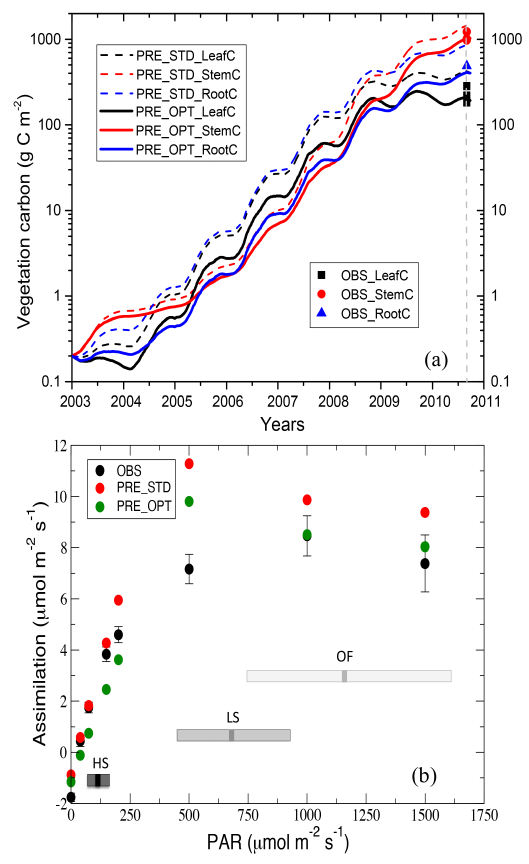
Figure 3. (a) CLM simulated change of leaf carbon (PRE_STD_LeafC), stem carbon (PRE_STD_StemC), and root carbon (PRE_STD_RootC) with default parameters and change of those (PRE_OPT_LeafC, PRE_OPT_StemC, and PRE_OPT_RootC) simulated with optimized parameters for the pretreatment period between year 2003 and 1 Septem- ber 2010 (dashed gray line). Observational estimations of leaf (OBS_LeafC; 221.1, 283.8, and 181.9gCm − 2 ), stem (OBS_StemC; 1011.2, 973.8, and 1220.1gCm − 2 ), and root (OBS_RootC; 488.4gCm − 2 ) are based on measured stem diam- eters at breast height and allometric relationships from similarly aged loblolly pine (Baldwin and Feduccia, 1987; Naidu et al., 1998; Vanlear et al., 1986). Note that y axis is log-10 scaled. (b) Comparison of observed and simulated light response of top of the canopy leaves of loblolly pine at the PiTS-1 site. Solid black circles are mean ± 1 SD of observations. Solid red and green circles are simulated results from the net photosynthesis module of the functional unit testing framework using site-observed parameters (PRE_STD) and optimized parameters (PRE_OPT), respectively (see Sect. 2.2.2). Simulations are with the mean observed internal CO 2 concentrations and leaf temperatures at the observed light (PAR) levels and the site’s observed leaf nitrogen. Three gray bars represent the mean ± 1 SD of midday PAR levels under the light shade treatment, heavy shade treatment, and open field